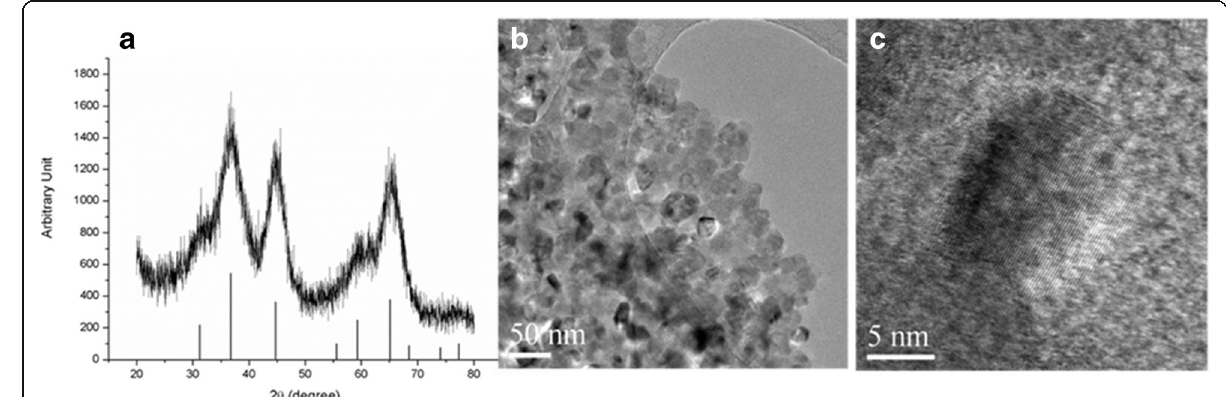
Fig. 1 a XRD pattern for Ti-doped nano MgAl 2 O 4 powder synthesized at 500 °C 1 h with reference peaks of MgAl 2 O 4 from JCPDS and b , c TEM images of the